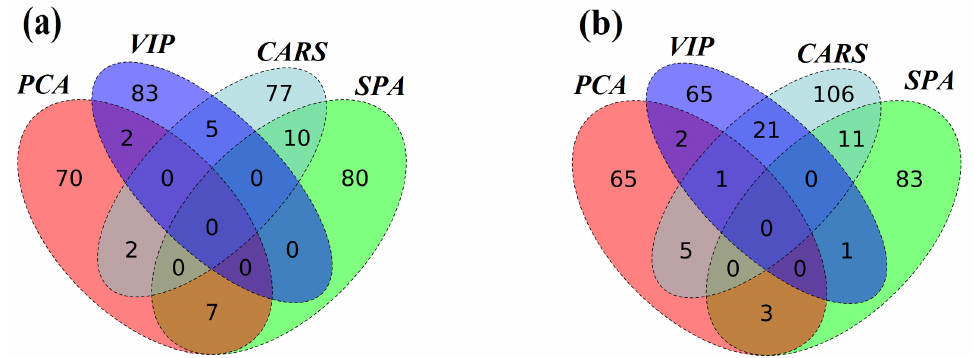
Figure 5. The intersections of the effective wavelengths from the PCA, SPA, VIP, and CARS effective spectral selection algorithms. ( a ) The intersections of the effective wavelengths for the optimal models in sesame oil adulterated with soybean oil. ( b ) The intersections of the effective wavelengths for the optimal models in rapeseed oil adulterated with soybean